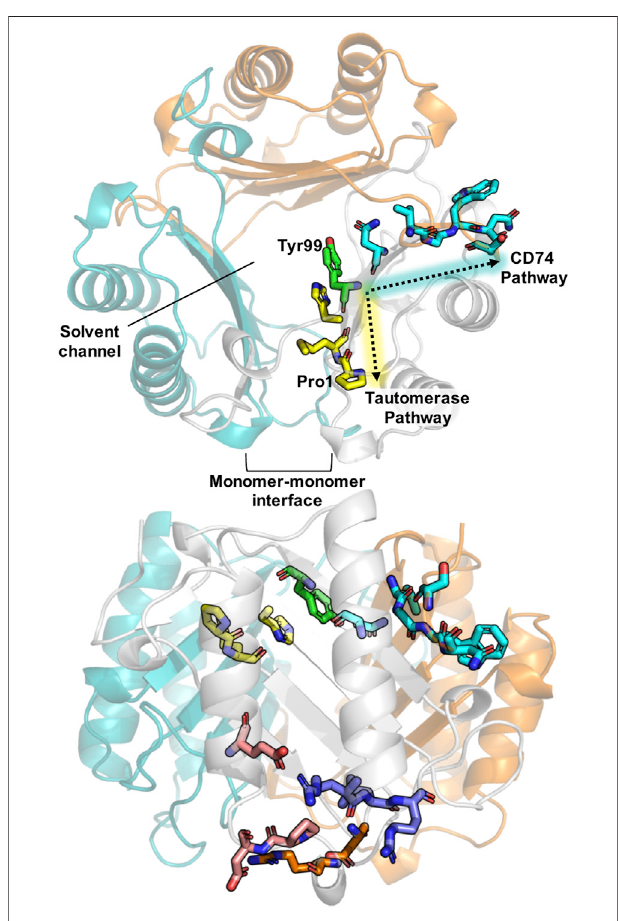
FIGURE1| SchematicofimportantstructuralfeaturesinMIF.Atopview of the MIF trimer (top structure) shows the monomeric subunits in gray, teal, and orange (PDB: 1MIF). Previously characterized allosteric pathways controlling tautomerase activity and pro-in fl ammatory CD74 activation are denoted in yellow and teal, respectively, including the common allosteric node, Tyr99, highlighted in green. Pro-1, the catalytic base for tautomerization, and the monomer-monomer interface, essential for catalysis, are also indicated. A side pro fi le of MIF (bottom structure) highlights the allosteric residues and sites shown above, as well as regions of the protein involved in binding to the receptors CXCR4 (purple) and CXCR2 (orange), and residues implicated in nuclease activity